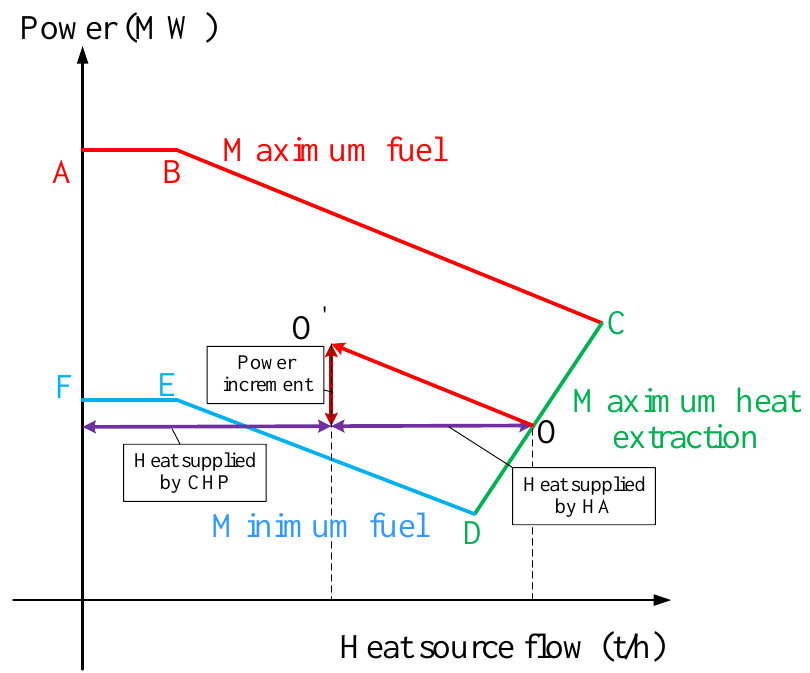
Figure 3. Diagram of accelerating power ramp rate of CHP units through HA.